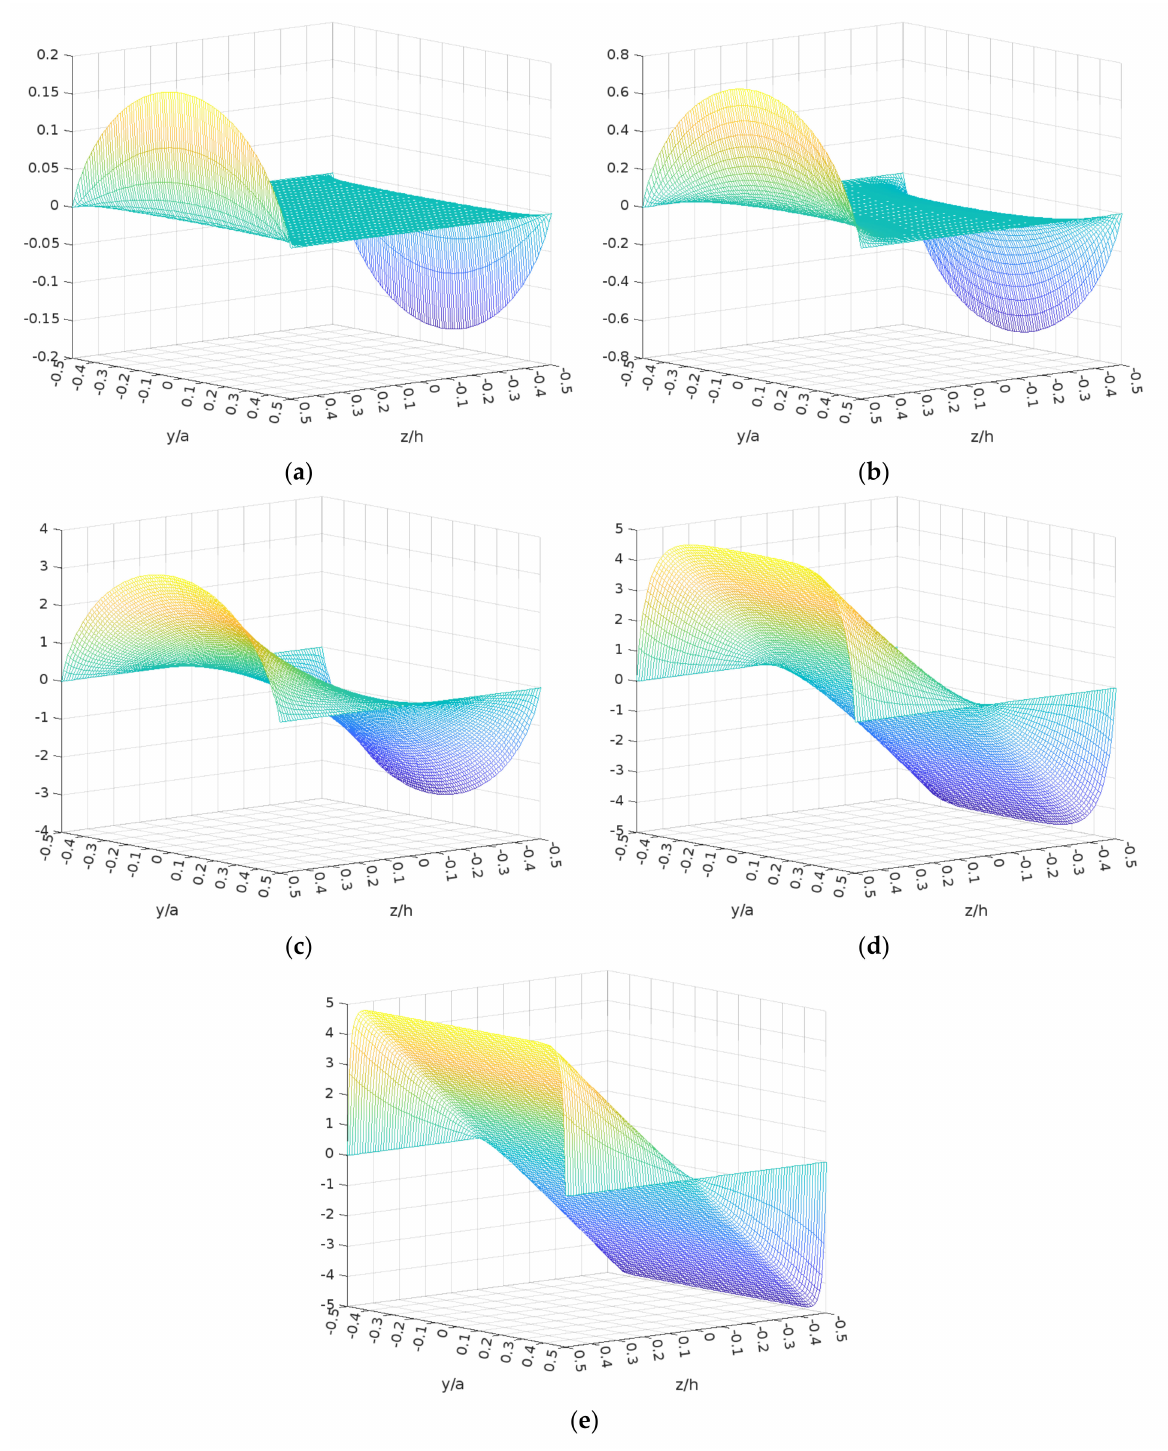
Figure 4. τ xz π 2 J /2 aT verse y / a and z / h ( a ) c = 0.05; ( b ) c = 0.2; ( c ) c = 1; ( d ) c = 5; ( e ) c =